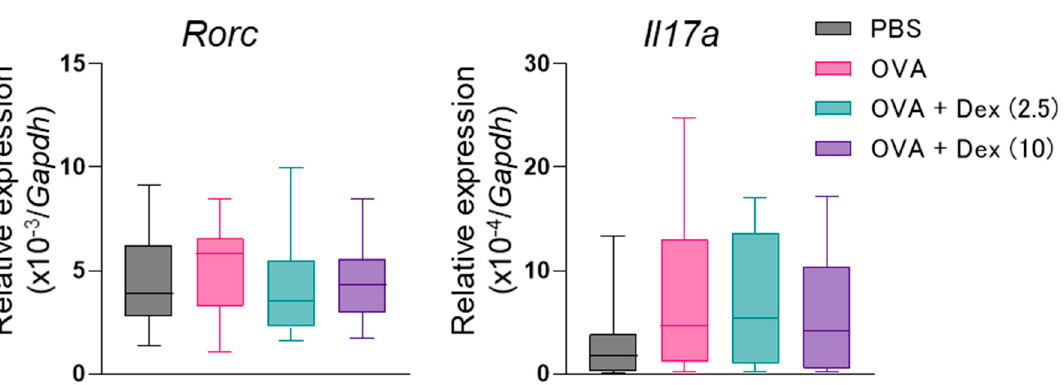
Figure 4. Effect of dexamethasone (Dex, 2.5 or 10 mg/kg) on gene expression in the nasal-associated lymphoid tissue (NALT) of Th17 cell-transferred mice. Expression of Rorc and Il17a mRNA in the NALT was evaluated. Data are displayed as the box plot of 6–11 mice. PBS, phosphate-buffered saline; OVA, ovalbumin.